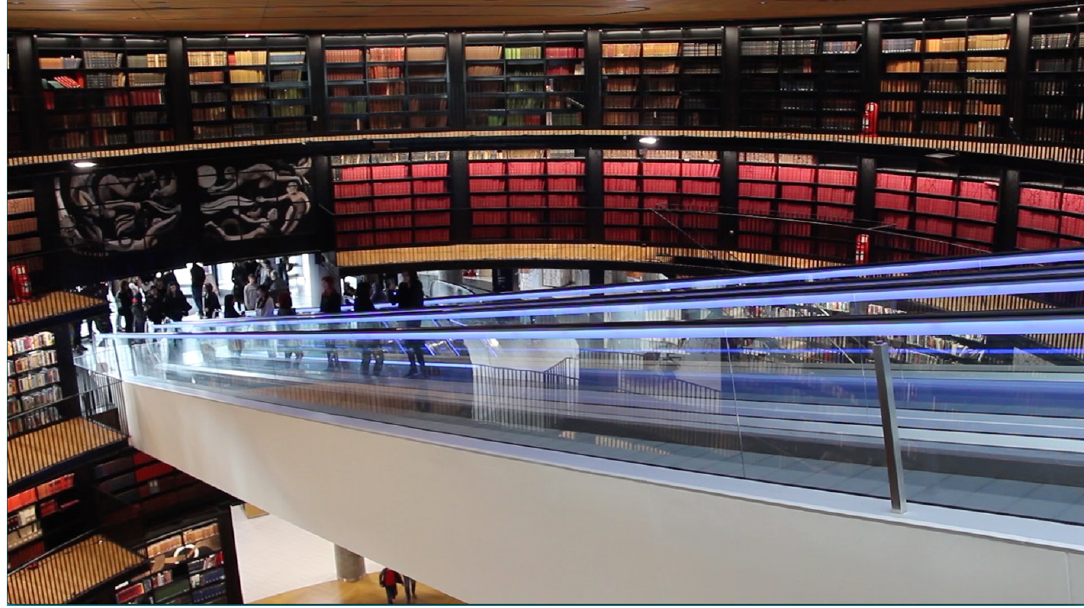
Figure 5. Translation Zone(s): A Stuttering (2016). Digital video still of participants performing on the travelator in the Library of